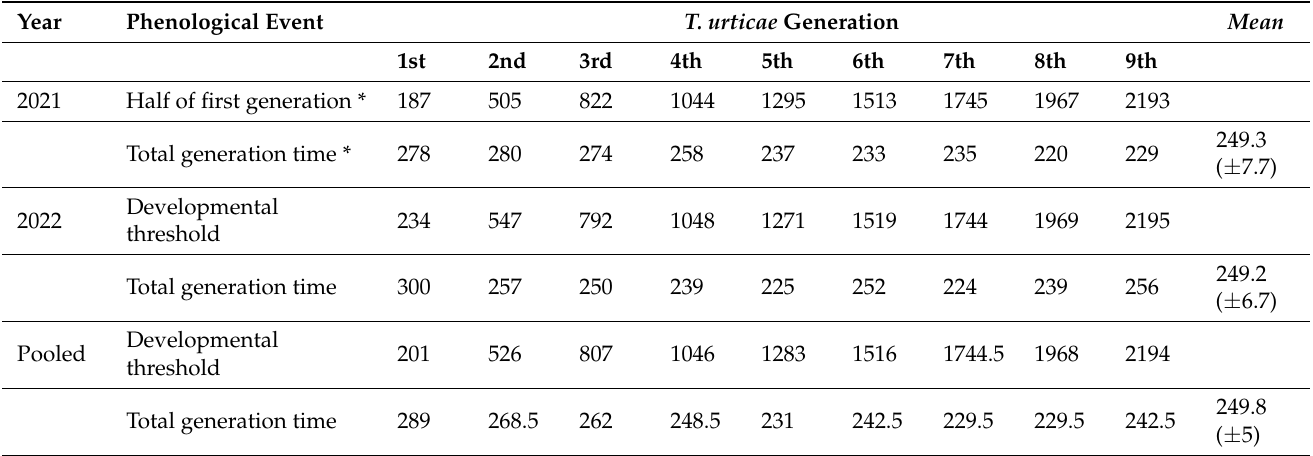
Table 2. Degree-day developmental heat summation risk thresholds of total egg to adult T. ur- ticae development in respect to corresponding predictions generated by the developmental rate summation